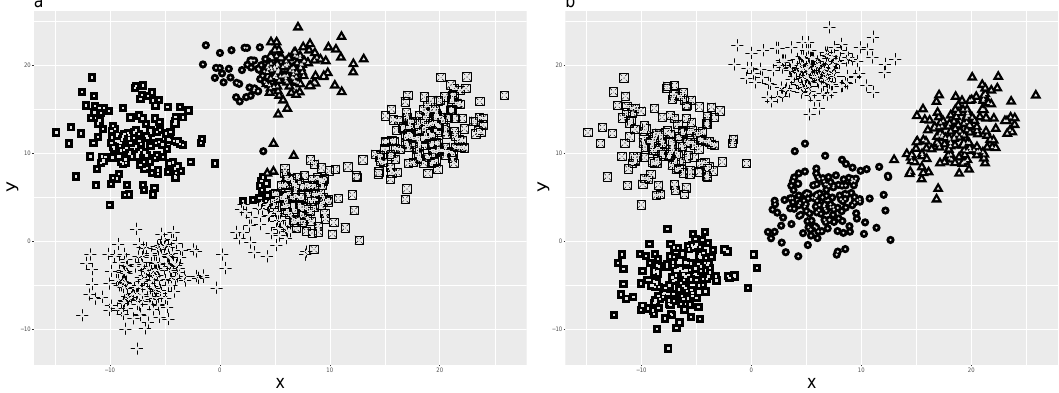
Figure 1. The simple and fast k-medoids (SFKM) ( a ) and simple k-medoids (SKM) ( b ) partitioning